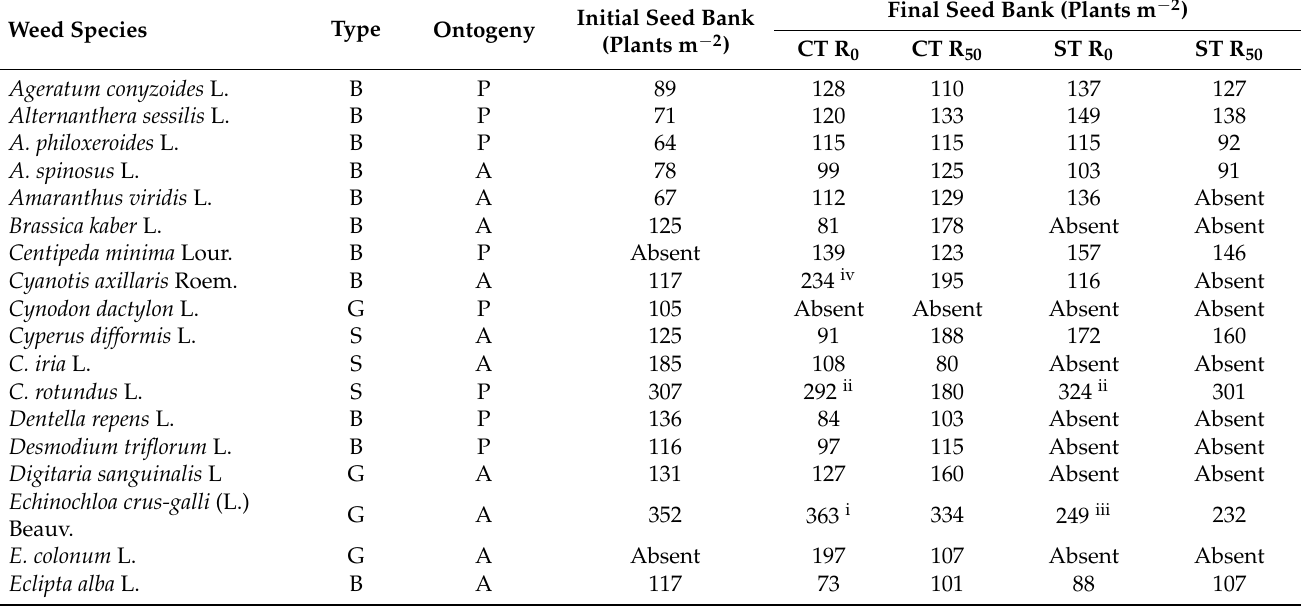
Table 4. Composition of initial and final soil seed bank at 5–10 cm depth under different treatments (on average for